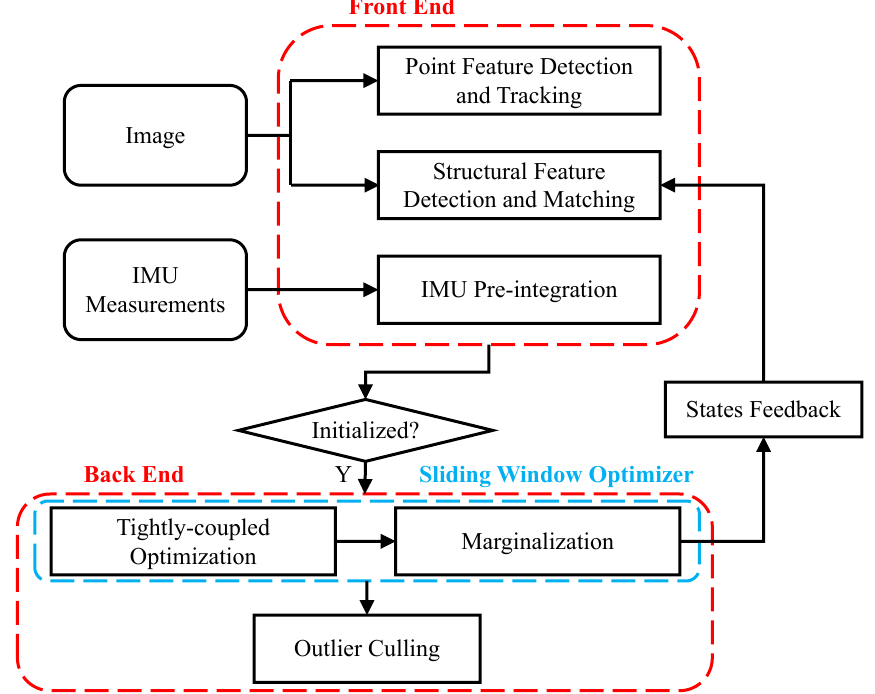
Figure 1. Pipeline of the proposed visual-inertial odometry